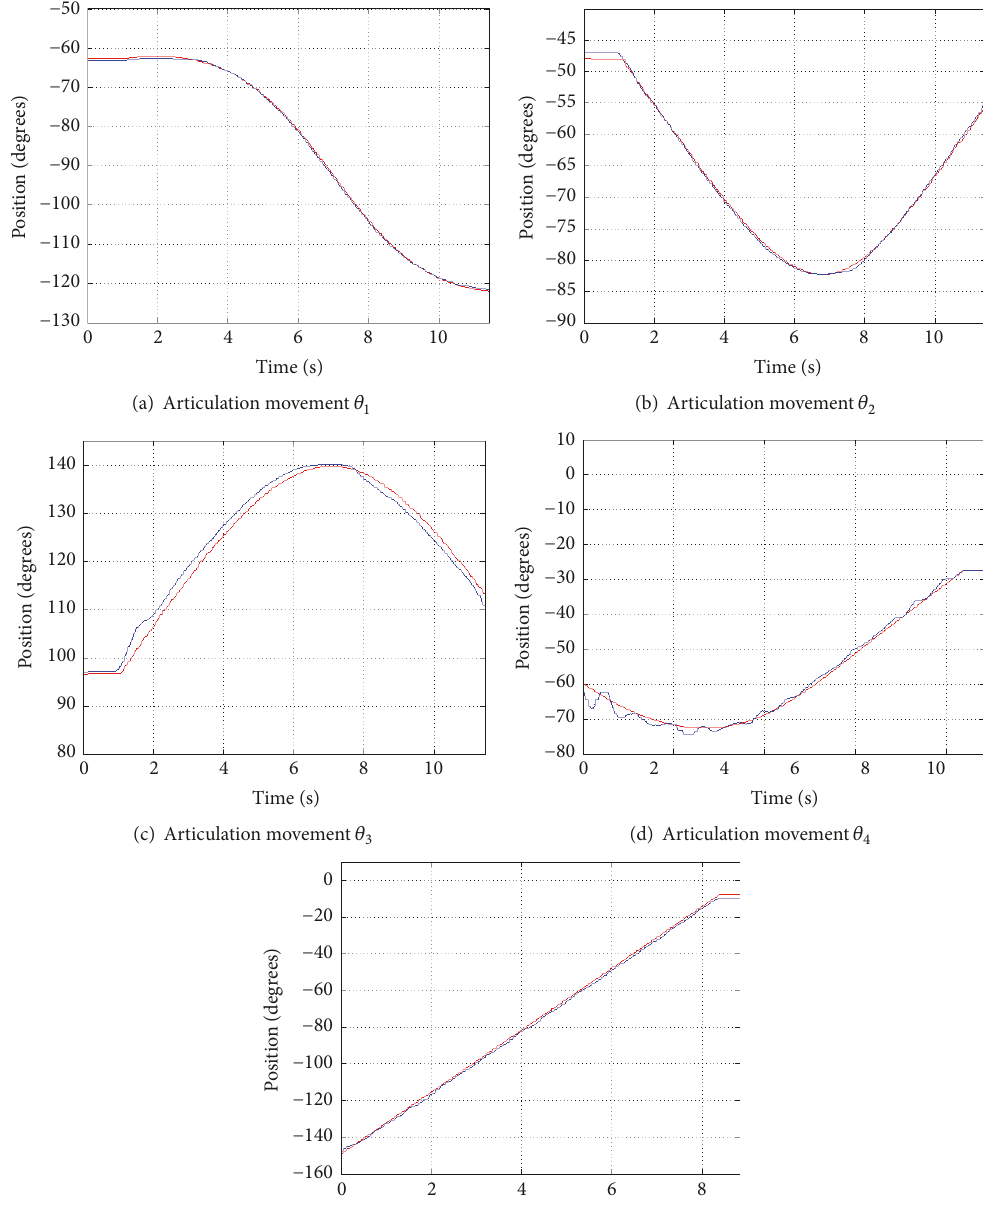
Figure 16: Joint movement of the MOVEJ